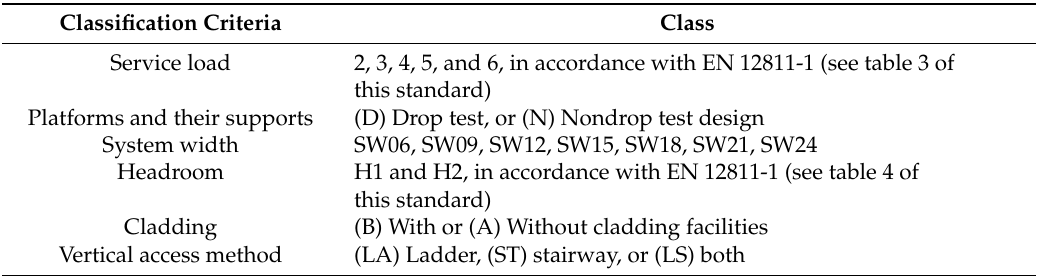
Table 2. Different classes of scaffolding according to different criteria set by standard EN 12810 ‐ 1. Classification Criteria